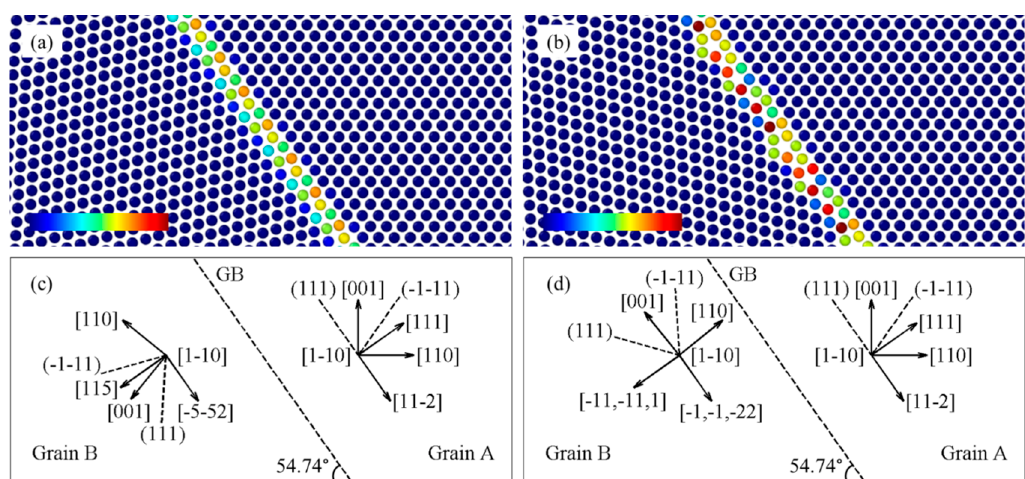
Figure 6. Relaxed GB structures and misalignments of the slip systems across neighboring grains. ( a ) and ( c ): Cu bicrystal with the dense boundary; ( b ) and ( d ): Cu bicrystal with the loose boundary. Atomic snapshots are taken along the 111 tilt axis (points out of the paper). Atoms are colored according to the centrosymmetry parameter. The blue end of the color bar corresponds to zero, while the red end of the color bar corresponds to ten. Table 1. Geometric parameters of the asymmetric tilt boundaries.